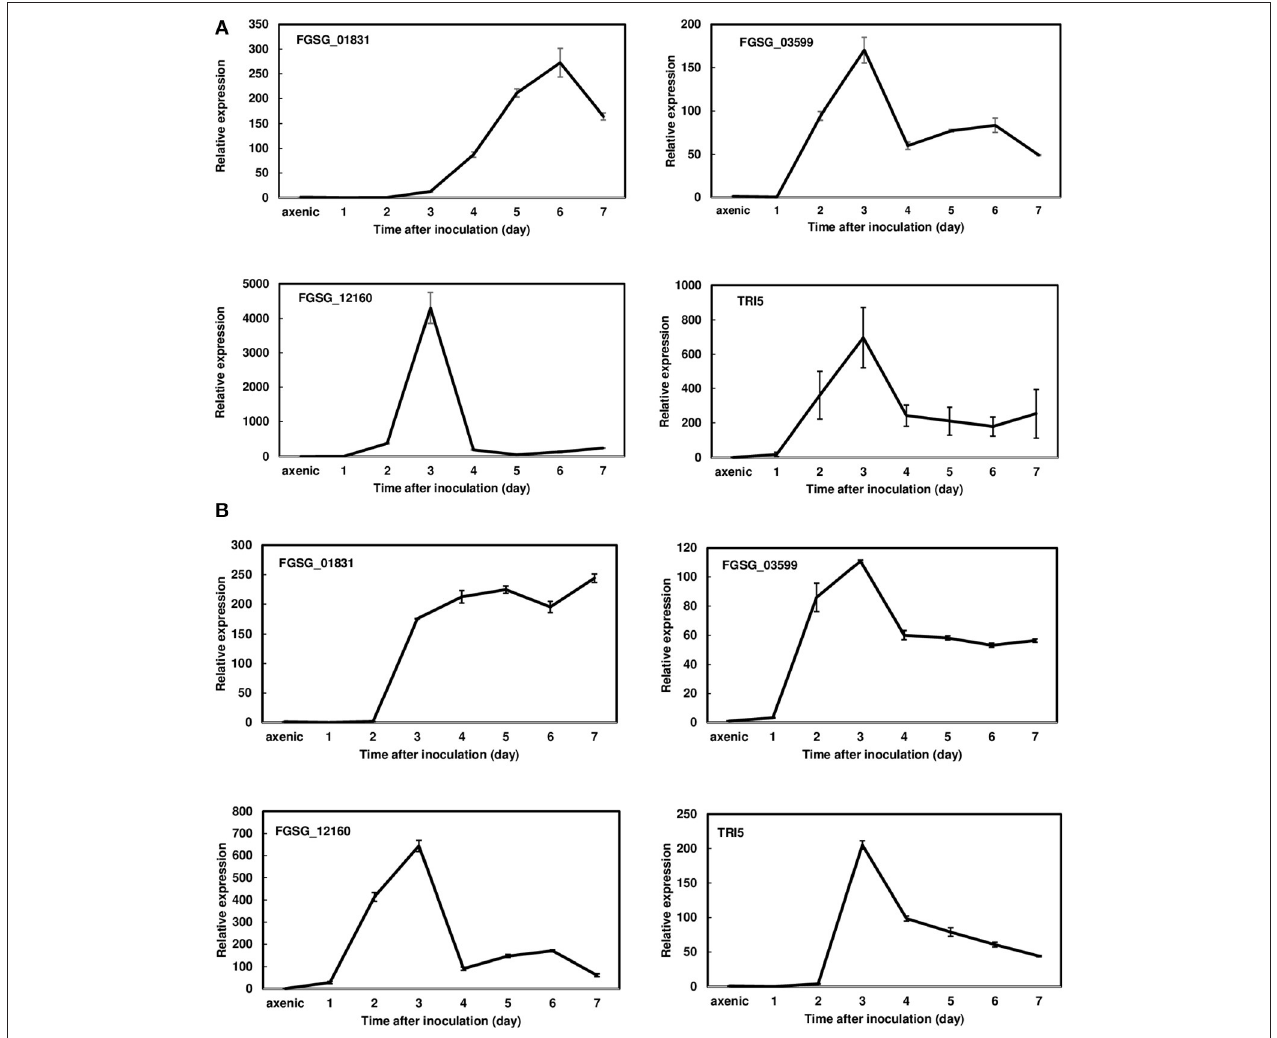
FIGURE 2 | Gene expression profiles of FGSG_01831 , 03599 , 12160 , and TRI5 from 1 to 7 days post inoculations (dpi) during wheat head infection. (A) Norm; (B) Alsen. Wheat heads were collected at 1, 2, 3, 4, 5, 6, and 7 dpi. Three biological replicates, each replicate containing two heads, were collected at each time point and used for RNA isolation and cDNA synthesis. Gene expression was determined by RT-qPCR. Fungal β -tubulin was used as an internal control for transcript normalization. Fold changes of gene expression were relative to axenic culture, which was grown on V8 plates for 7 days. Two technical replicates were used for each